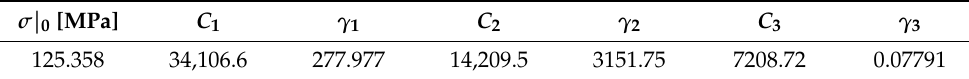
Table 5. Fitted constants of the Chaboche model for AlSi10Mg